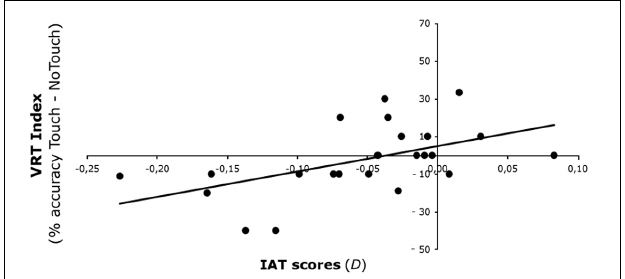
FIGURE 2 | Experiment 1 results. Relationship between VRT effect for Outgroup faces and IAT scores. IAT scores (on the x -axis) predicted the VRT effect (on the y -axis)—expressed as the difference in detection of bilateral tactile stimulation in the Touch and No-Touch fingers’ trajectory